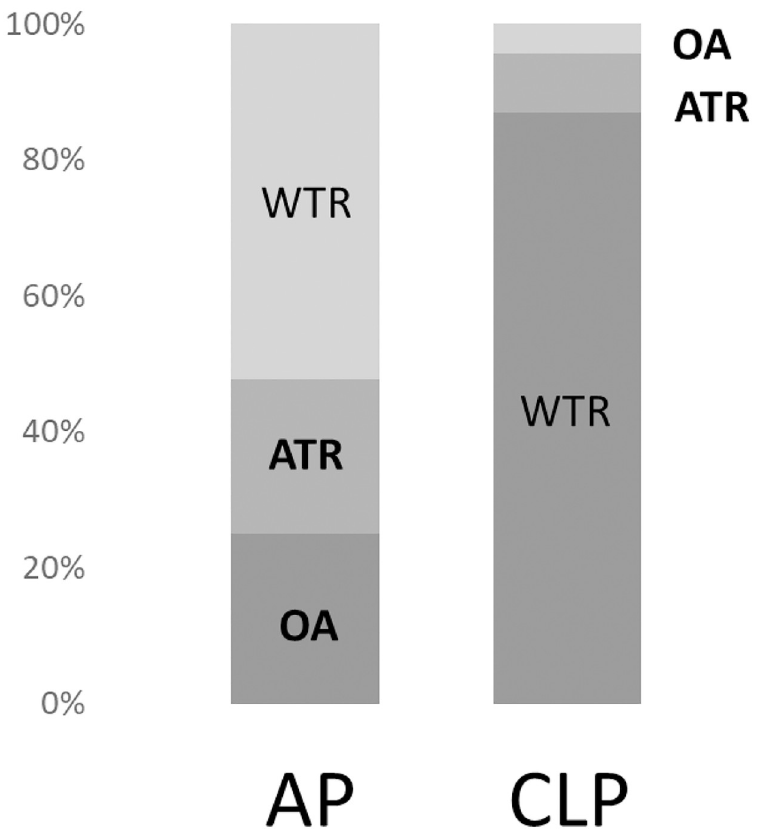
Fig 1. Proportions of the preoperative astigmatism type in the acquired ptosis (AP) and contact lens-related ptosis (CLP) groups. WTR: With-the-rule; ATR: Against the rule; OA: Oblique astigmatism.